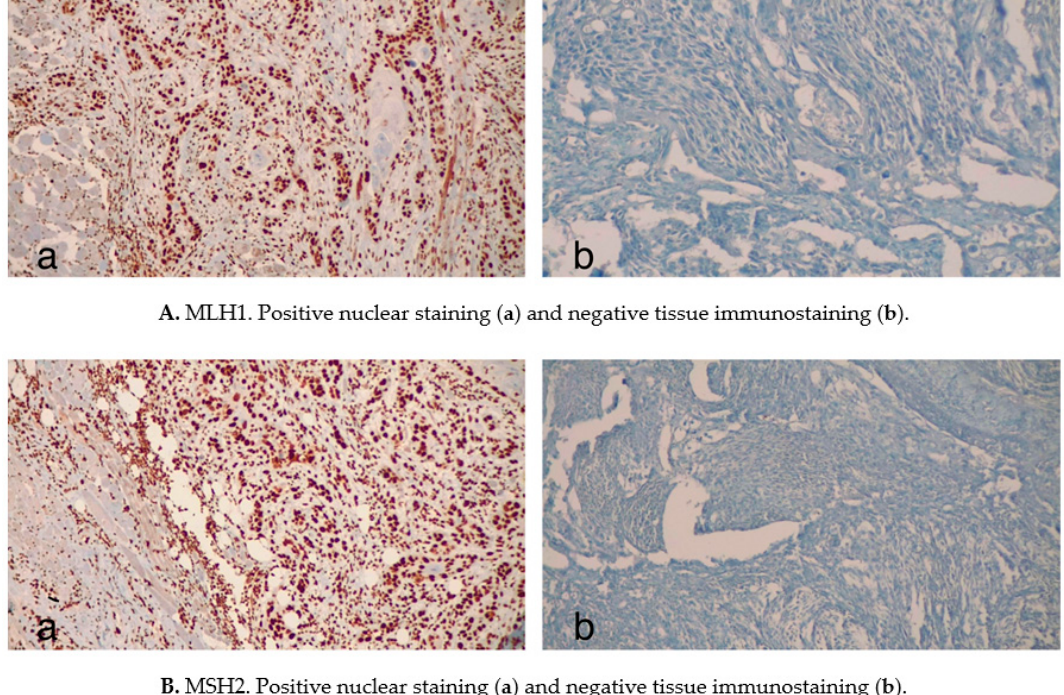
Figure 3. SomeillustrativeexamplesofMMRexpressionpatternsinHNCspecimens. Immunohistochemical Figure 3. Some illustrative examples of MMR expression patterns in HNC specimens. staining (IHC), which is performed to determine the expression of MMR components such as MLH1 ( A ) or Immunohistochemical staining (IHC), which is performed to determine the expression of MMR MSH2 ( B ), represents a useful tool to discriminate between MMR proficient / deficient tissues. All images are components such as MLH1 ( A ) or MSH2 ( B ), represents a useful tool to discriminate between MMR shown at 20 × magnification. Images reproduced with permission from the archives of the Department of proficient/deficient tissues. All images are shown at 20× magnification. Images reproduced with Pathology, Careggi University